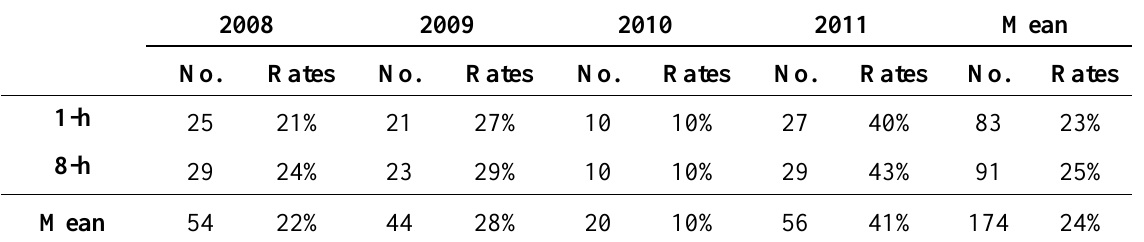
Table 2. Exceed-standard days and exceed-standard rates in Tangshan during the past four years.